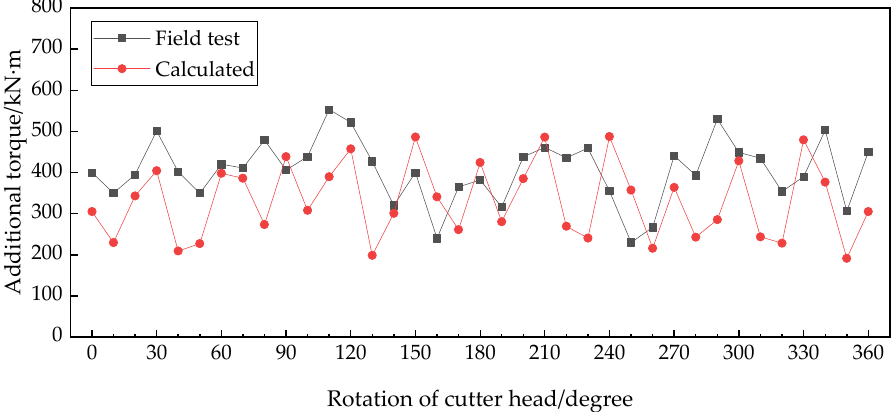
Figure 12. Additional torque in different rotation angles (pile No. 1, B = 800 mm, e = 0.2 D).